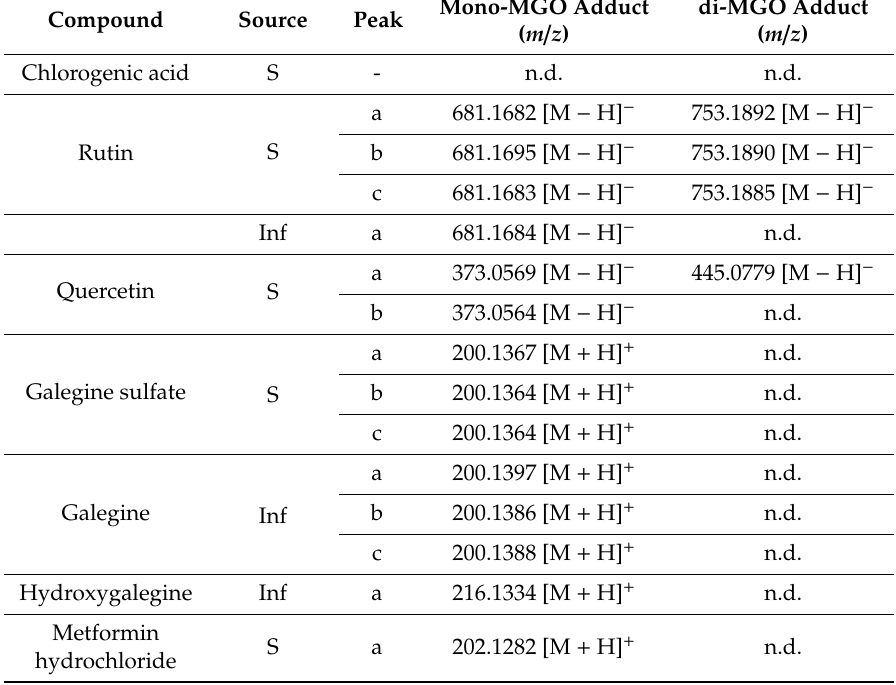
Table 4. Methylglyoxal adducts detected in the reaction mixture of standard compounds and water infusion of G. o ffi cinalis after 1 h incubation with MGO. Quercetin and metformin hydrochloride were used as a positive control. Mono-MGO Compound Source Peak